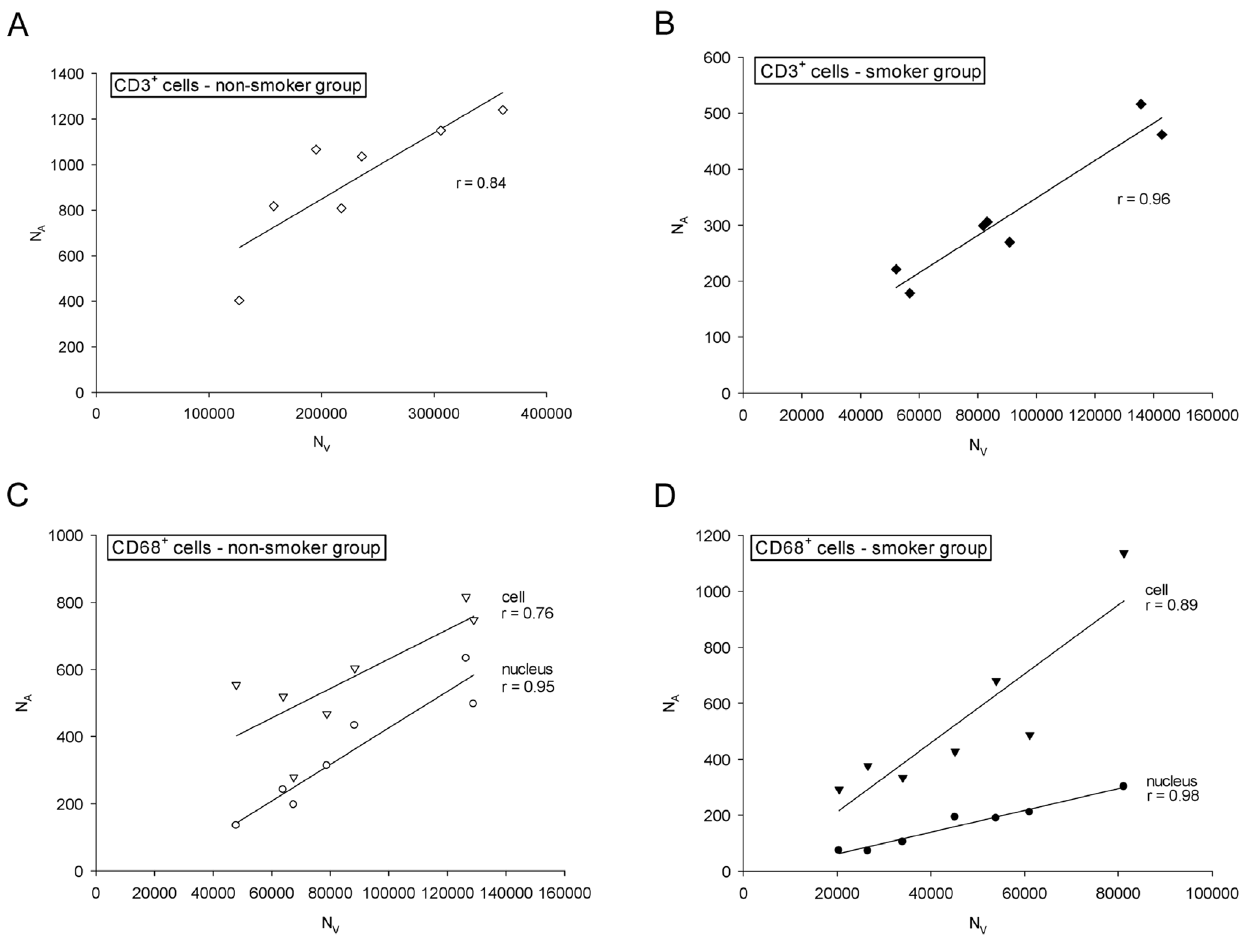
Figure 4. 2D profiles per unit area versus 3D numerical density. (a) T-lymphocytes, non-smokers, r=0.84, p =0.017; (b) T-lymphocytes, smokers, r=0.96, p , 0.001; (c) macrophages, non-smokers, r nucleus =0.95, p =0.001; r cell =0.76, p =0.046; (d) macrophages, smokers, r nucleus =0.98, p , 0.001; r cell =0.89, p =0.007